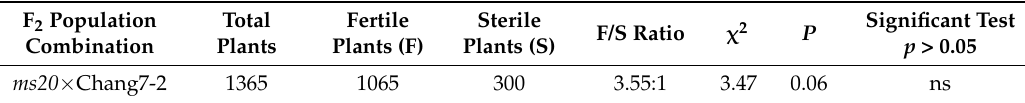
Table 1. The ratio of fertile to sterile plants in the F 2 population derived from the cross of ms20 ×